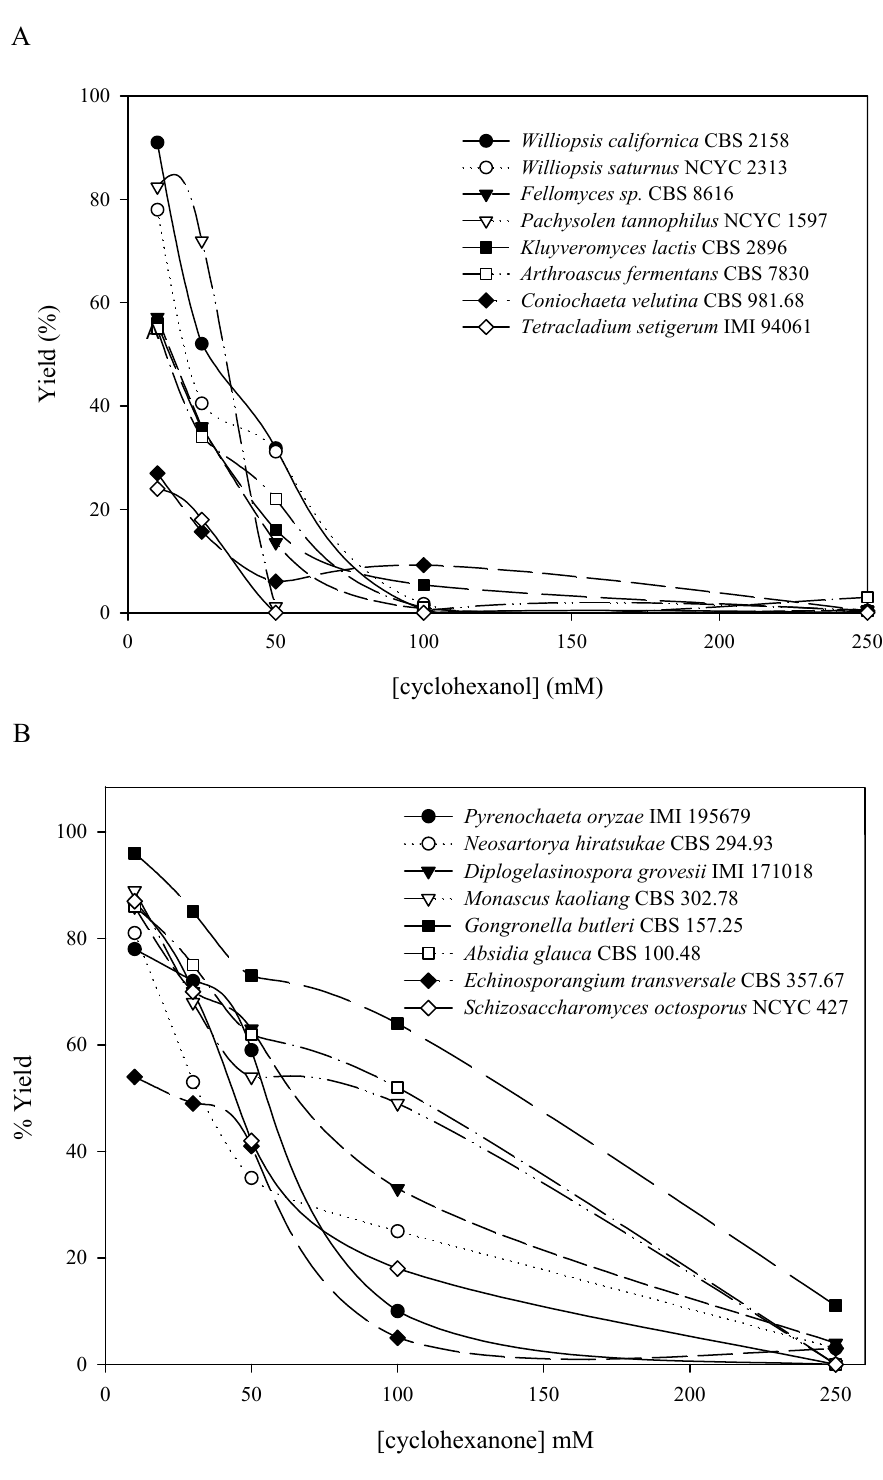
Figure 1. Comparison between the toxicity of cyclohexanol (Figure A) and of cyclohexanone (Figure B) at different concentrations for the selected strains (batch fermenting cells). T = 28 ºC. Reaction time = 72 h. Stirring speed = 250